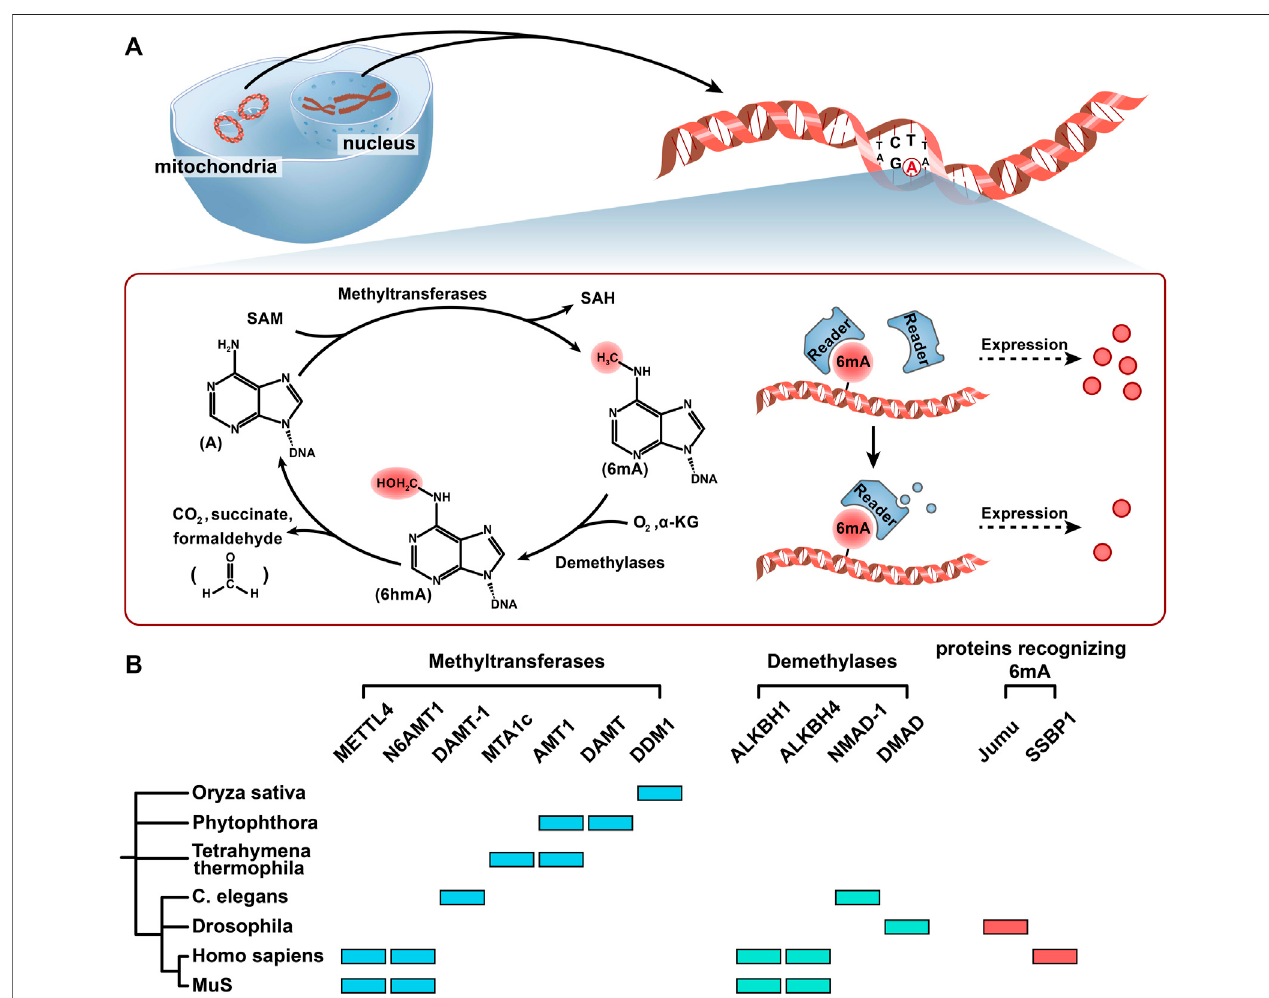
FIGURE 2 | Methylation and demethylation of 6 mA. (A) The methyl group on SAM was added to the sixth position of the adenine ring primarily with the help of methyltransferases. Under the catalysis of demethylase ALKBH1, 6 mA is oxidized to the 6 hmA intermediate by Fe 2+ , O 2 , and α -KG, and then 6 hmA spontaneously degrades to adenine and generates formaldehyde without the catalysis of demethylase. Readers (proteins recognizing 6 mA) may recognize the 6 mA modi fi cation and manipulate the fate of 6 mA-modi fi ed genes in different cellular contexts. (B) Seven kinds of 6 mA methyltransferases, four kinds of 6 mA demethylases, and two kinds of proteins recognizing 6 mA in 7 different organisms are shown in a simpli fi ed phylogenetic tree. Color codes represent the methyltransferases, demethyltransferases, and proteins recognizing 6 mA in the corresponding organism and proteins.